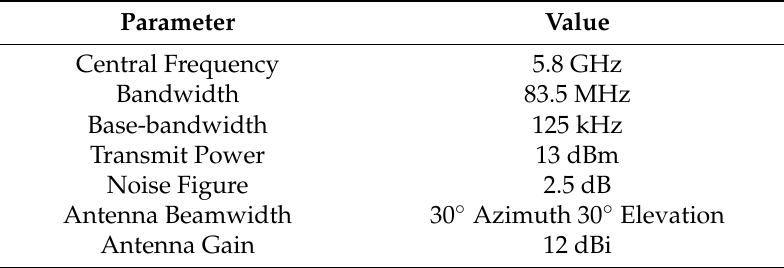
Figure 2. Geometry of the experimental setup showing individual walking up and down centrally within living room space and radar deployed at 43 cm distance.